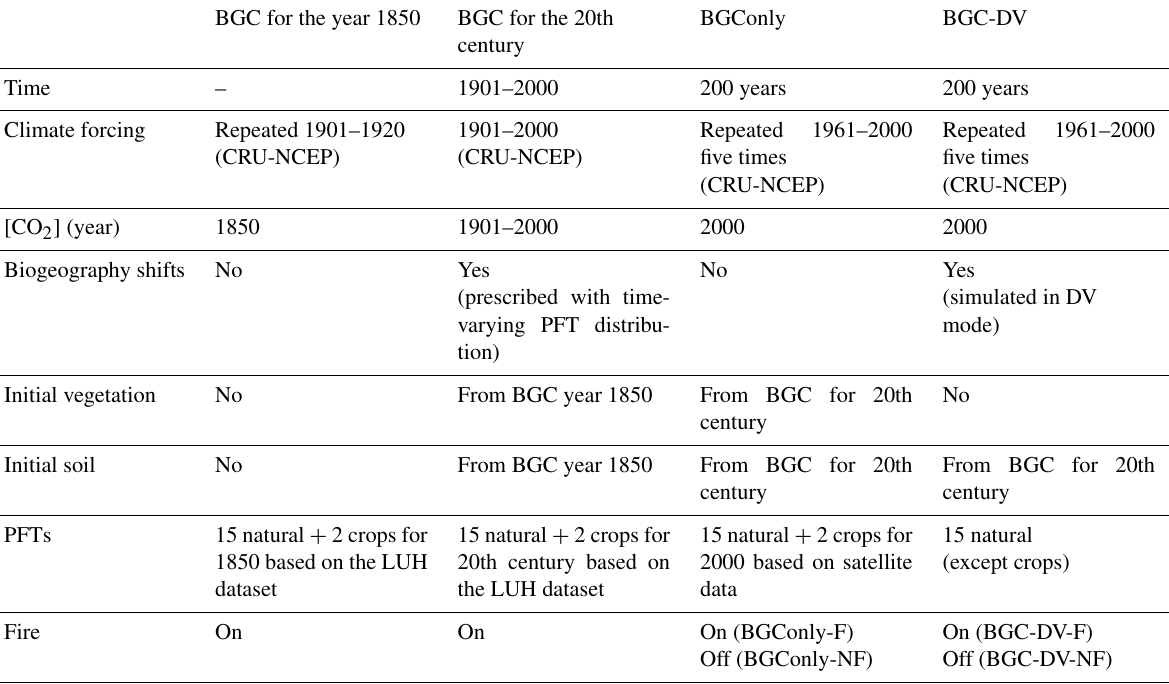
Table 1. Configurations of the experiments used in the